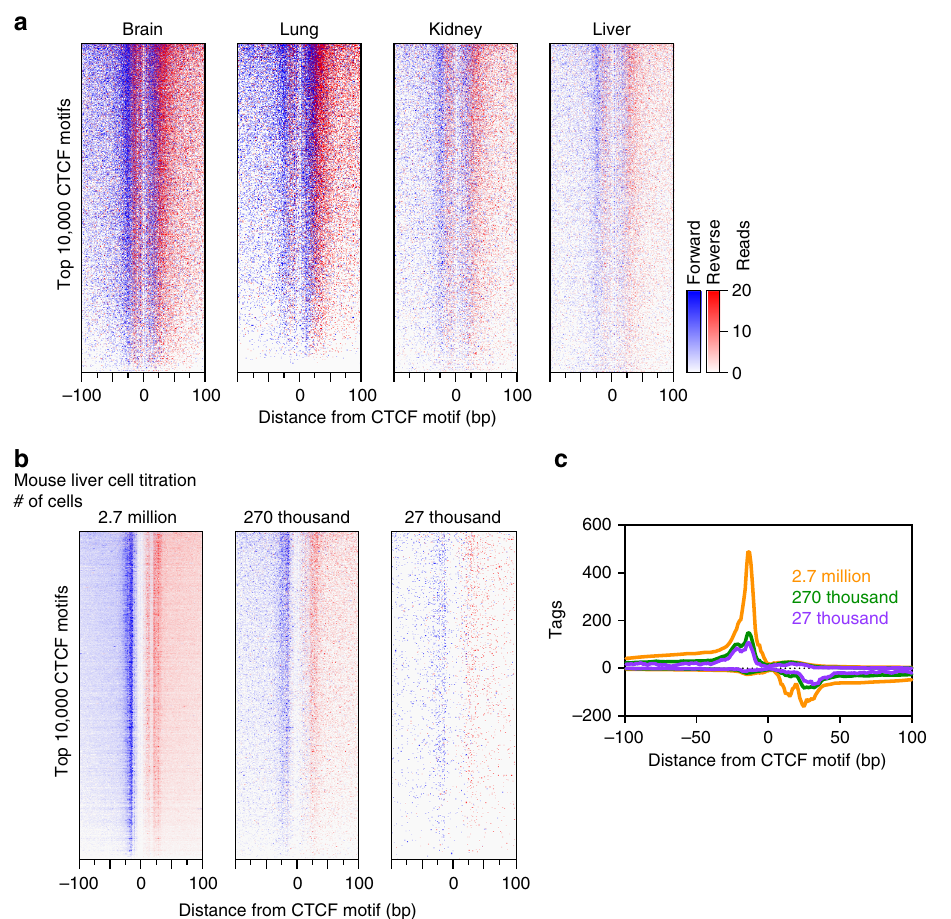
Fig. 6 ChIP-exo 5.0 data from mouse organs. Heatmaps of ChIP-exo 5.0 CTCF ( a ) across multiple organs or ( b ) in a liver cell titration at the top 10,000 M. musculus CTCF motifs in a 200 bp window. Rows were sorted by the average rank order of the four datasets in ( a ) by tag counts in a 200 bp window centered on the motif midpoint. Heatmaps are linked. c Composite plot of data in ( b